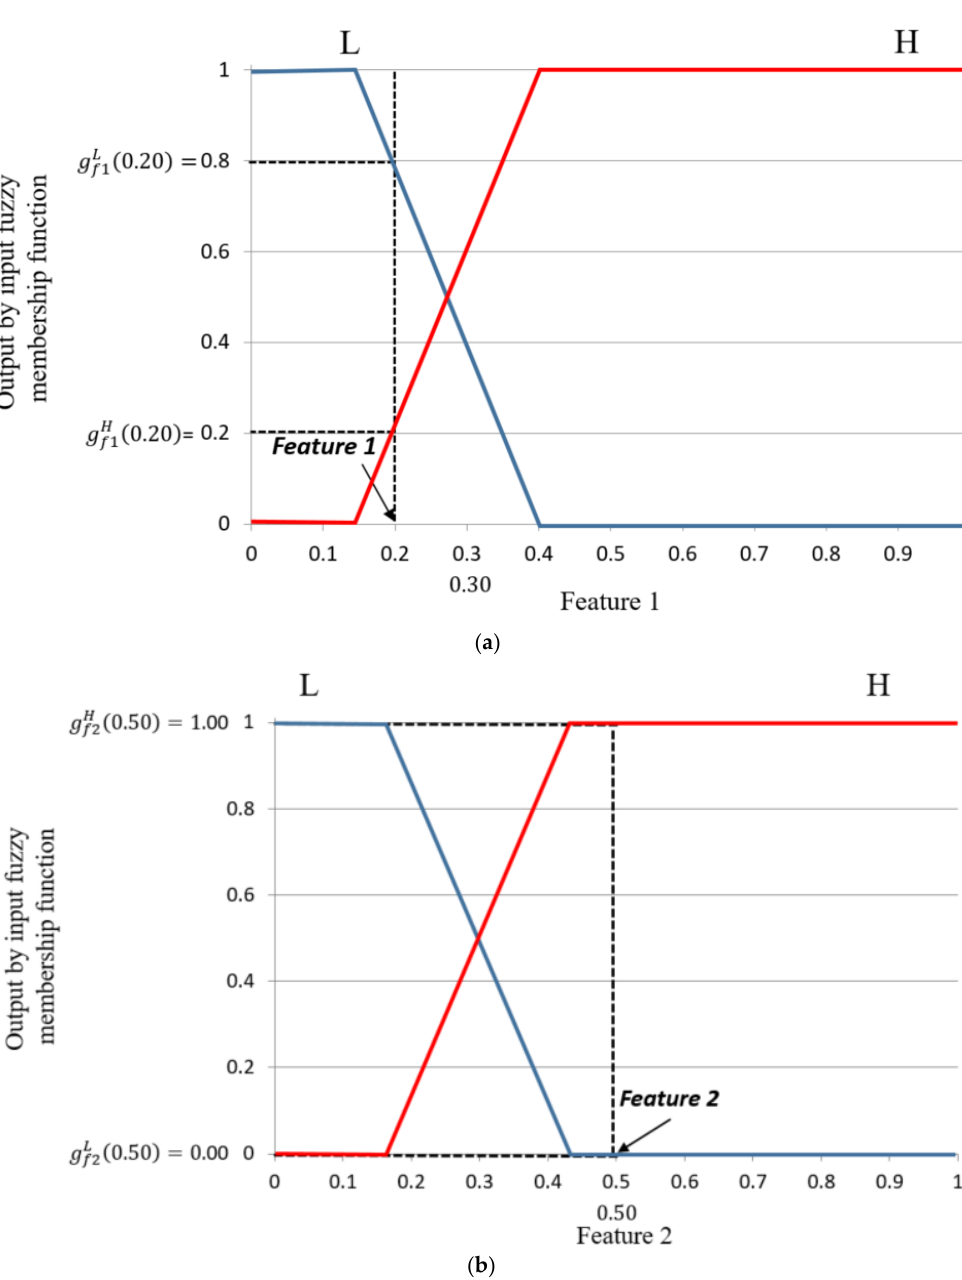
Figure 11. Obtaining the output value of the input membership function for two features: ( a ) feature 1; ( b ) feature 2.